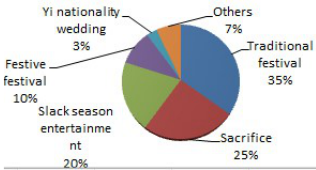
Figure 3-1 The time distribution of the wrestling of the Yi